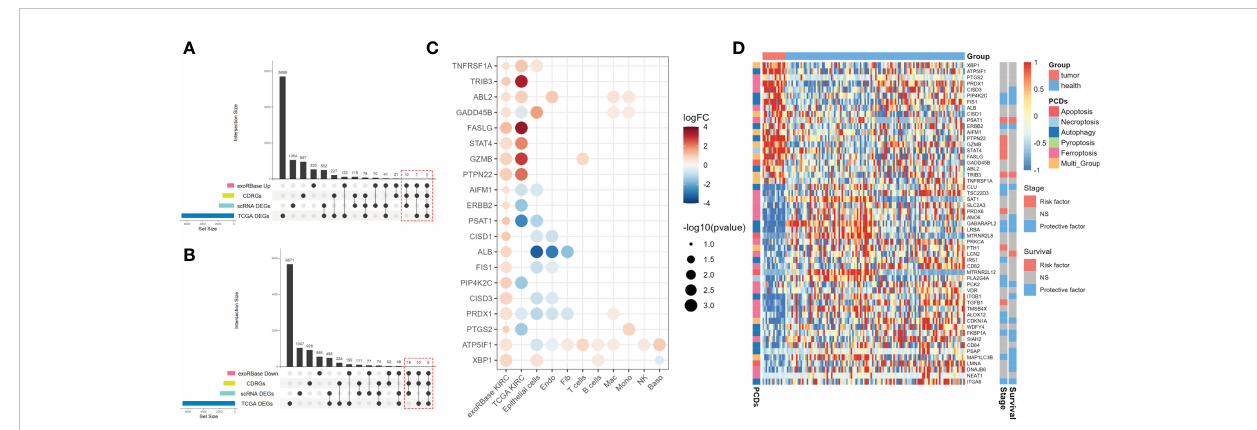
FIGURE 4 Screen for candidate biomarker genes. (A) UpSet plots showing the intersection analysis among cell death-related genes (CDRGs), differentially expressed genes (DEGs) in exoRBase kidney renal clear cell carcinoma (KIRC) cohort, upregulated DEGs in The Cancer Genome Atlas (TCGA) KIRC cohort, and scRNA datasets. (B) UpSet plots showing the intersection analysis among CDRGs, DEGs in the exoRBase KIRC cohort, downregulated DEGs in the TCGA KIRC cohort, and scRNA datasets. (C) The bubble plots show 20 candidate biomarker genes upregulated in the exoRBase KIRC cohort and their expression pattern in other datasets. Red circles represent positive logFC values or upregulated DEGs in corresponding datasets, while blue circles represent negative logFC values or downregulated DEGs in corresponding datasets; the bubble size indicates negative log10( P - value). (D) Heat map showing the expression levels of 53 candidate biomarker genes in the exoRBase KIRC cohort, with red color indicating relatively high expression and blue color indicating relatively low expression levels. The column annotations on the left side represent the programmed cell death classi fi cation of the candidate biomarker genes. The two annotated columns on the right side show the correlation of candidate biomarker gene expression with the survival outcome and clinical stage of the TCGA KIRC cohort, respectively. Red color represents the gene as a risk factor, and blue color represents a protective factor in the prognosis of KIRC